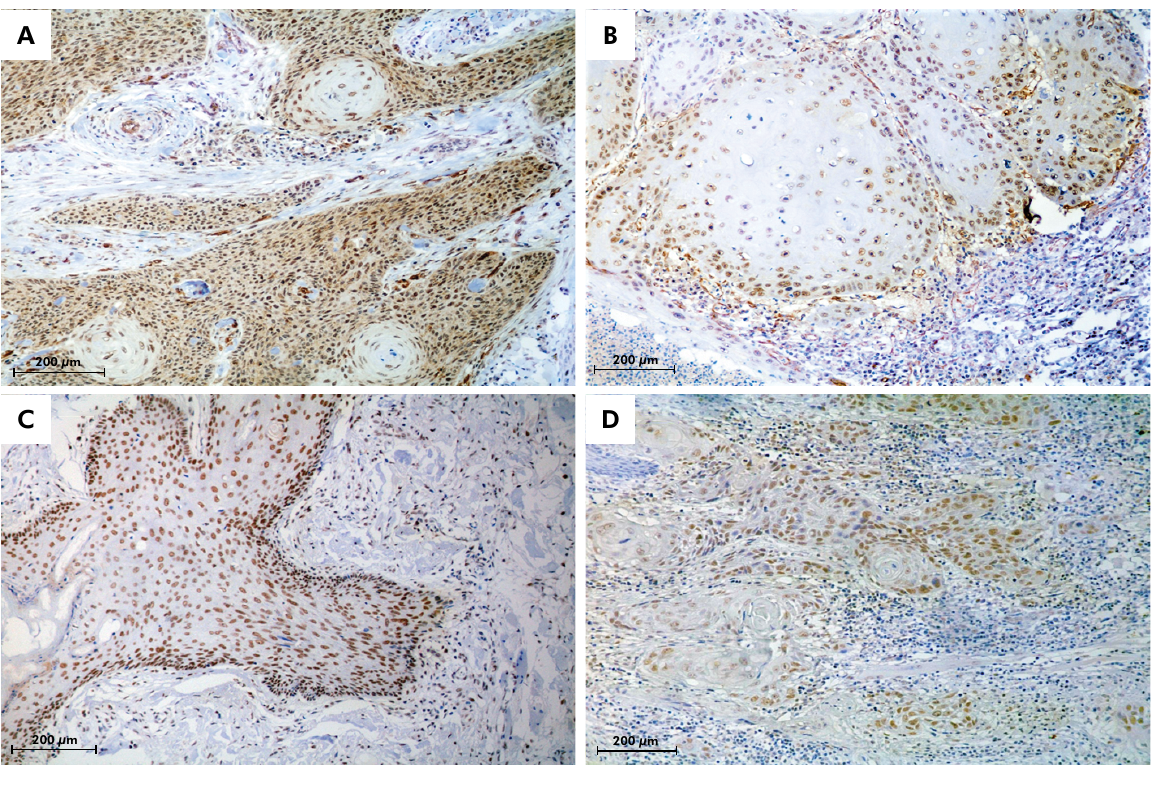
Figure. A. Immunoexpression of XPF protein at the tumor invasion front of lower lip squamous cell carcinoma (LLSCC): positive immunoexpression in the nucleus and cytoplasm of more than 50% of cells. B. Immunoexpression of XPF protein at the tumor invasion front of oral tongue squamous cell carcinoma (OTSCC): positive immunoexpression in 11 to 50% of cells. C. Immunoexpression of XRCC1 protein at the tumor invasion front of LLSCC: positive immunoexpression in 11 to 50% of cells. D. Immunoexpression of XRCC1 protein at the tumor invasion front of OTSCC: positive immunoexpression only in the nucleus of more than 50% of